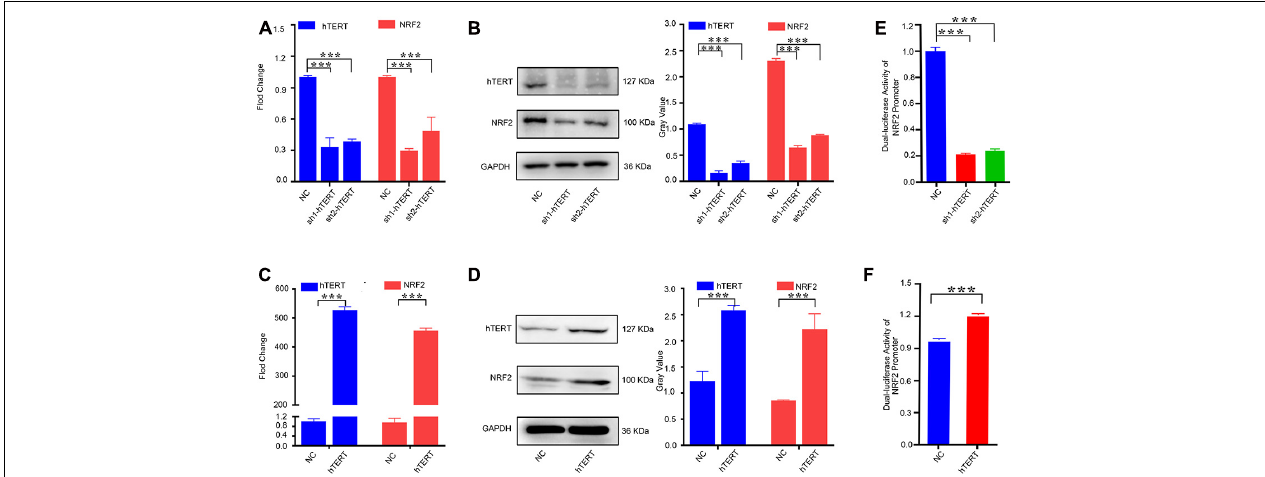
FIGURE 2 | Human telomerase reverse transcriptase (hTERT) upregulates NRF2 expression by promoting NRF2 transcriptional activity. (A) hTERT-knockdown cells were constructed by transfecting sh1-hTERT and sh2-hTERT lenviral respectively into HCT 116 cells. The hTERT and NRF2 mRNA expression level after downregulation of hTERT were identified by qRT-PCR. (B) hTERT and NRF2 protein expression levels after downregulation of hTERT were detected by western blotting (Left). Statistical analysis of western blotting (Right). (C) hTERT-overexpressed cell was constructed by transfecting hTERT lenviral into SW620 cells. The hTERT and NRF2 mRNA expression level after upregulation of hTERT was identified by qRT-PCR. (D) hTERT and NRF2 protein expression levels after overexpression of hTERT were detected by western blotting (Left). Statistical analysis of western blotting (Right). (E) Luciferase activity of the NRF2 promoter was detected after downregulation of hTERT. (F) Luciferase activity of NRF2 was detected after overexpression of hTERT. * p < 0.05; ** p < 0.01; *** p < 0.001; ns, no significance.